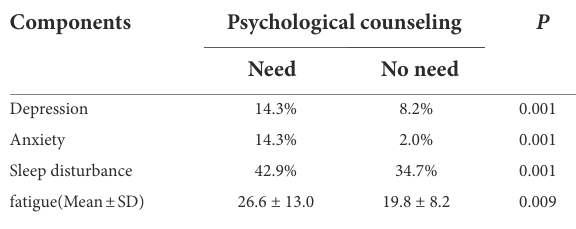
TABLE 3 The prevalence of depression, anxiety, sleep disturbance, and fatigue between patients needed for psychological counseling and no needed for psychological counseling during COVID-19